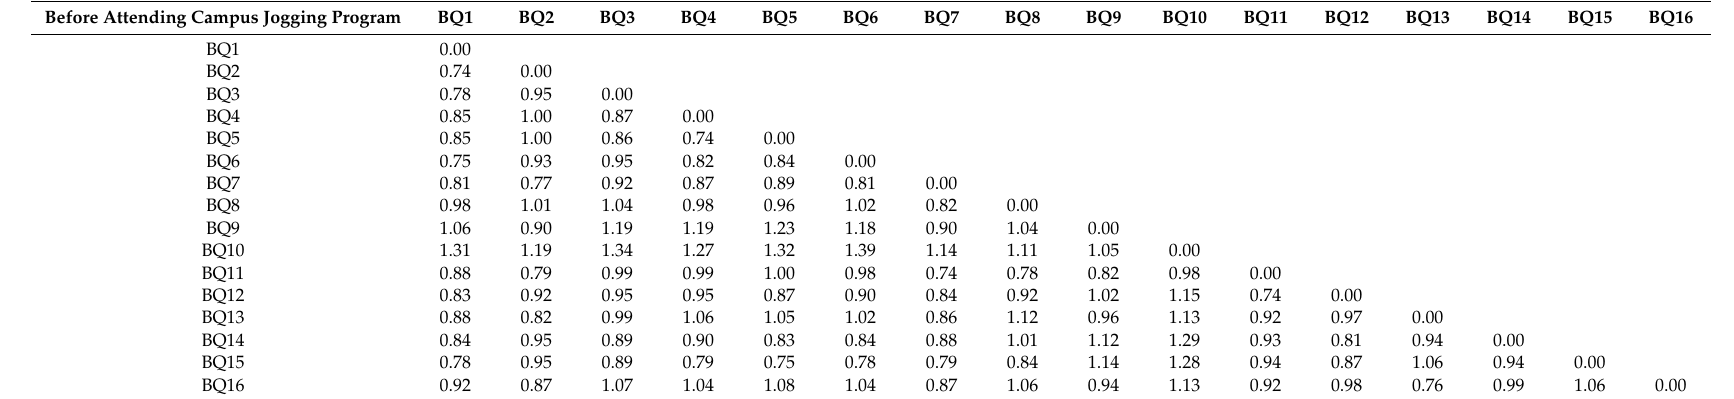
Table 4. Transformed proximities described by multidimensional scale (MS) before attending campus jogging program. Before Attending Campus Jogging